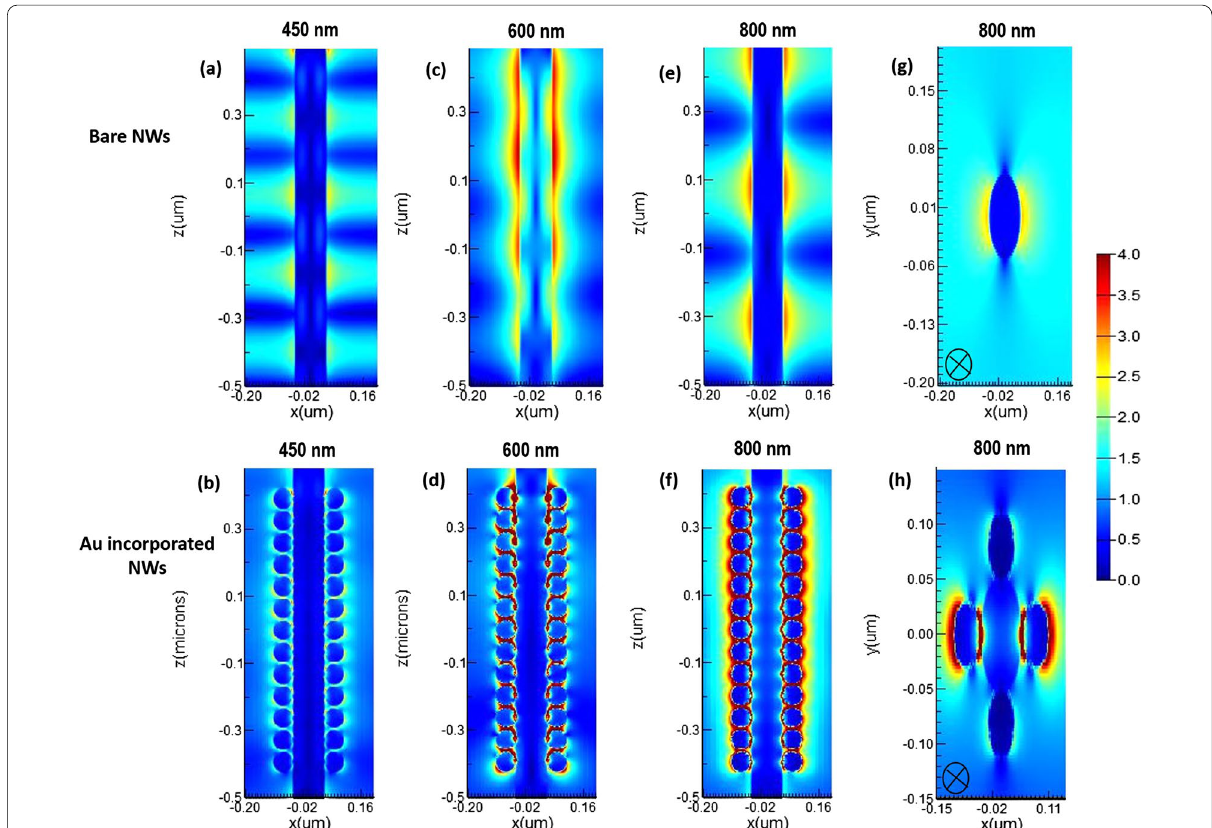
Fig. 6 Side view of the 2D light distribution for the bare GaAs nanowire at wavelengths a 450, c 600, and e 800 nm compared to the GaAs NW decorated with 60 Au NPs ( b ), ( d ), and ( f ). Figures g and h show the top view from Figures ( e ) and ( f ),